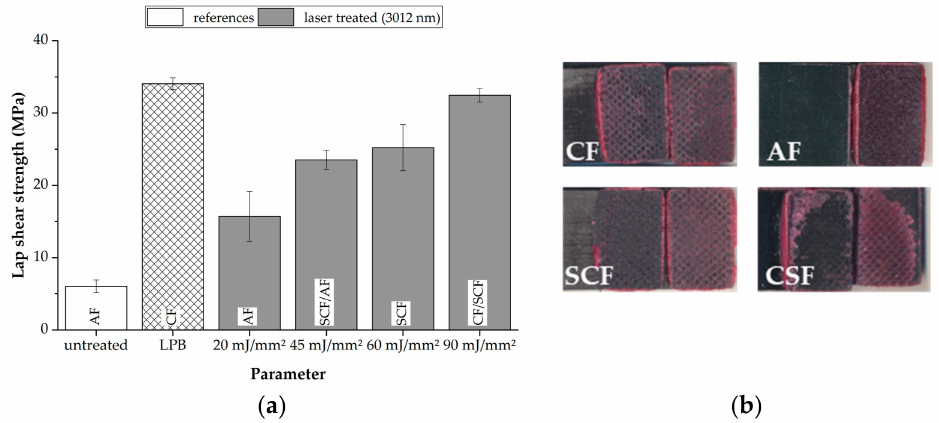
Figure 2. Lap shear results of differently treated samples ( a ) and representative fracture patterns ( b